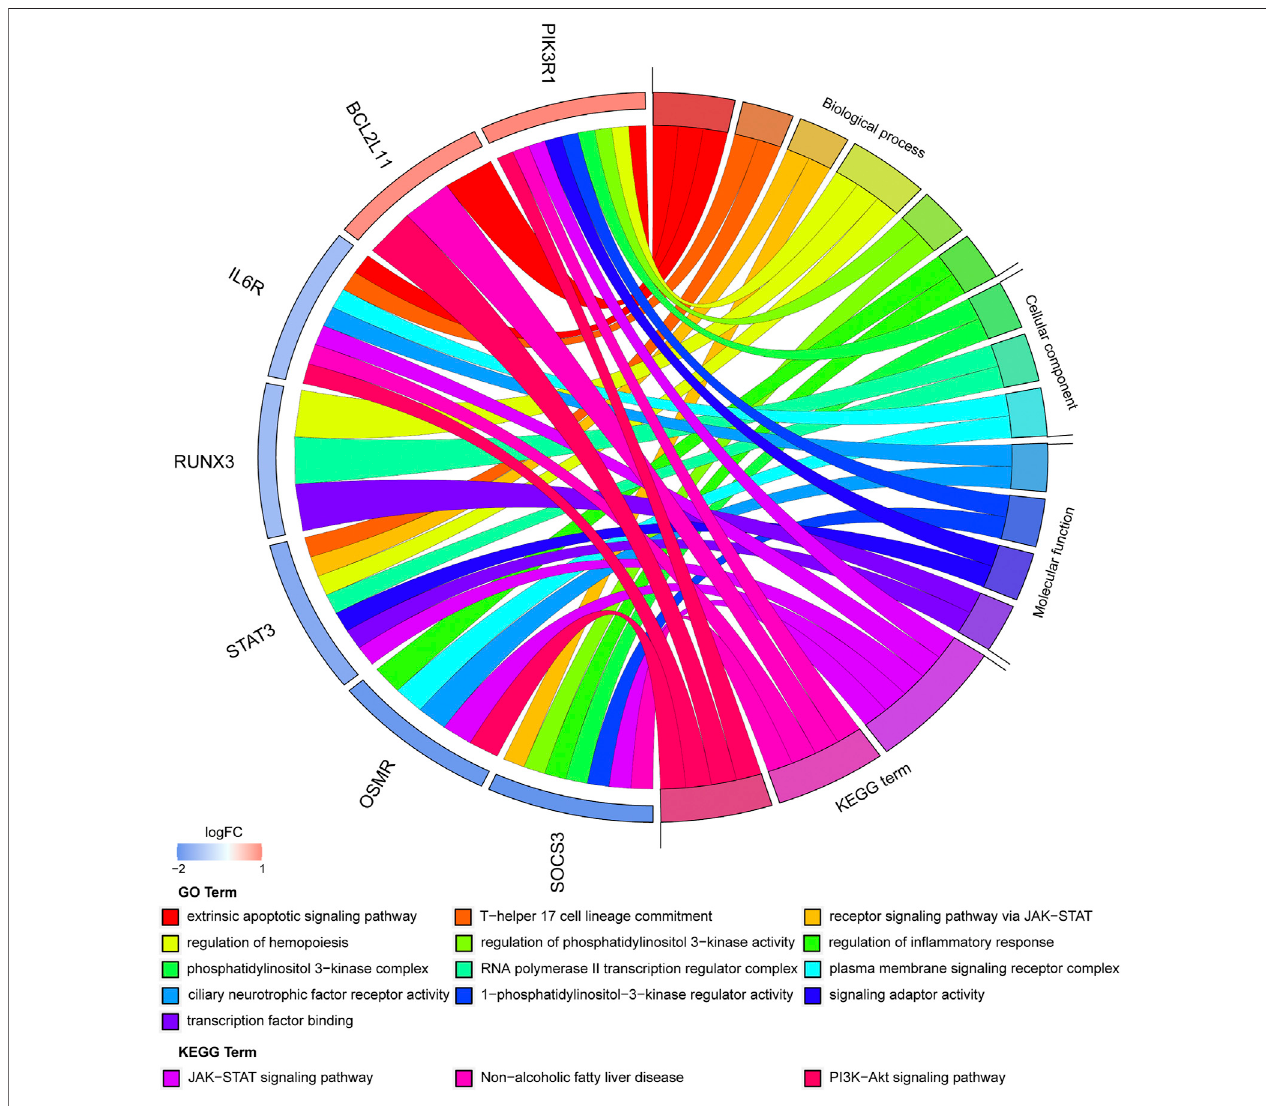
FIGURE 9 | Signi fi cantly enriched items GO analysis and KEGG pathway analysis of hub genes.